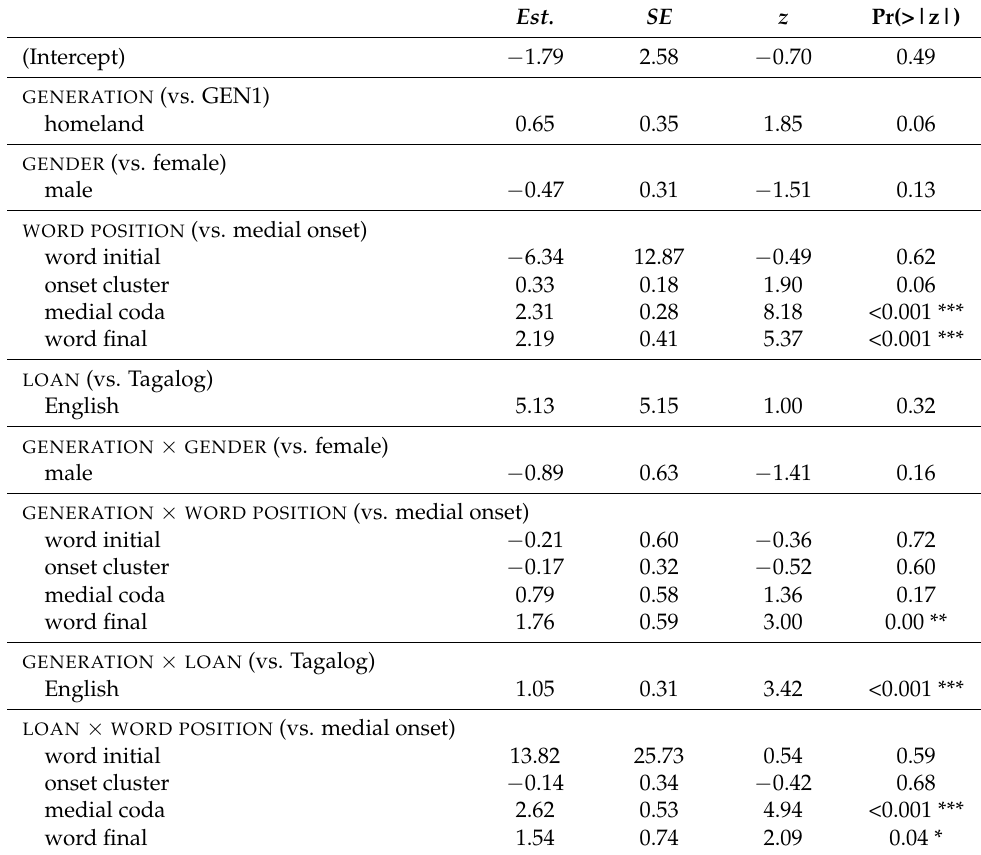
Table 8. Mixed-effects model for homeland and GEN1 speakers (n = 2085). Positive estimate values indicate a favoring environment for the approximant. Significance codes: <0.001 ‘***’; <0.01 ‘**’; <0.05